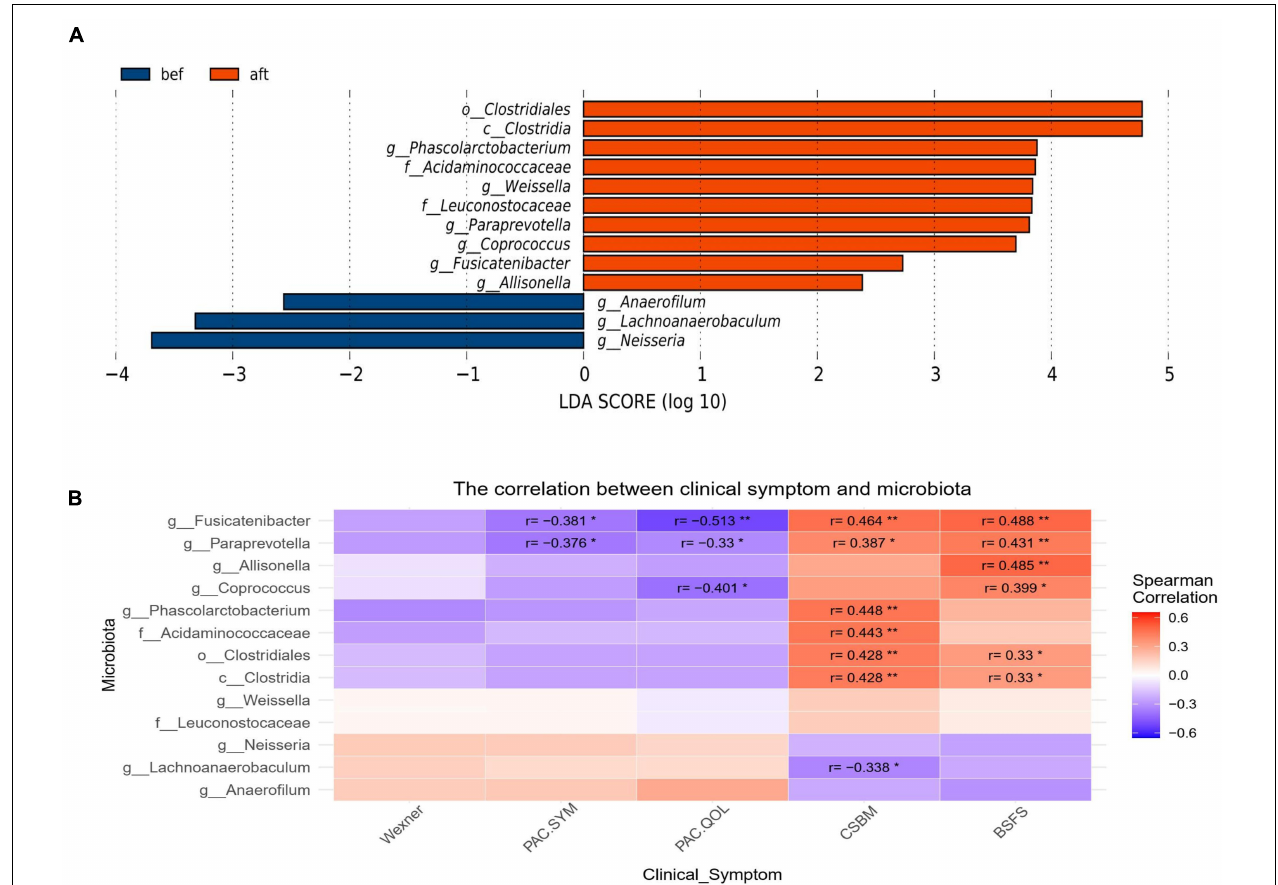
FIGURE 3 | (A) LEfSe analysis revealed significant changes in the fecal microbiota compositions before and after FMT. (B) Spearman correlation analysis revealed a correlation between patients’ clinical symptoms and the significantly altered bacteria from the LEfSe analysis. Fusicatenibacter , Paraprevotella , Allisonella , Coprococcus , Phascolarctobacterium , Acidaminococcaceae, Clostridiales, and class Clostridia were correlated with relief of patients’ constipation symptoms, and Lachnoanaerobaculum may be correlated with constipation severity (“*” represents 0.01 ≤ p < 0.05; “**” represents 0.001 ≤ p < 0.01).